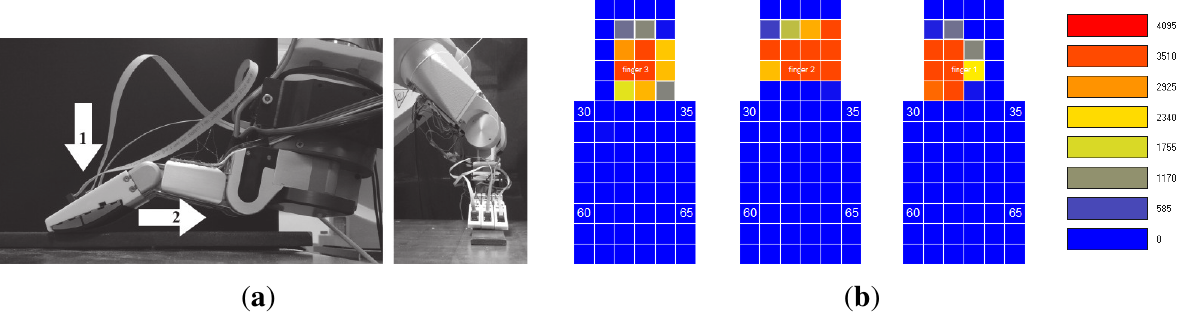
Figure 18. ( a ) Experimental setup with a matrix sensor; ( b ) graphical data of the three matrix